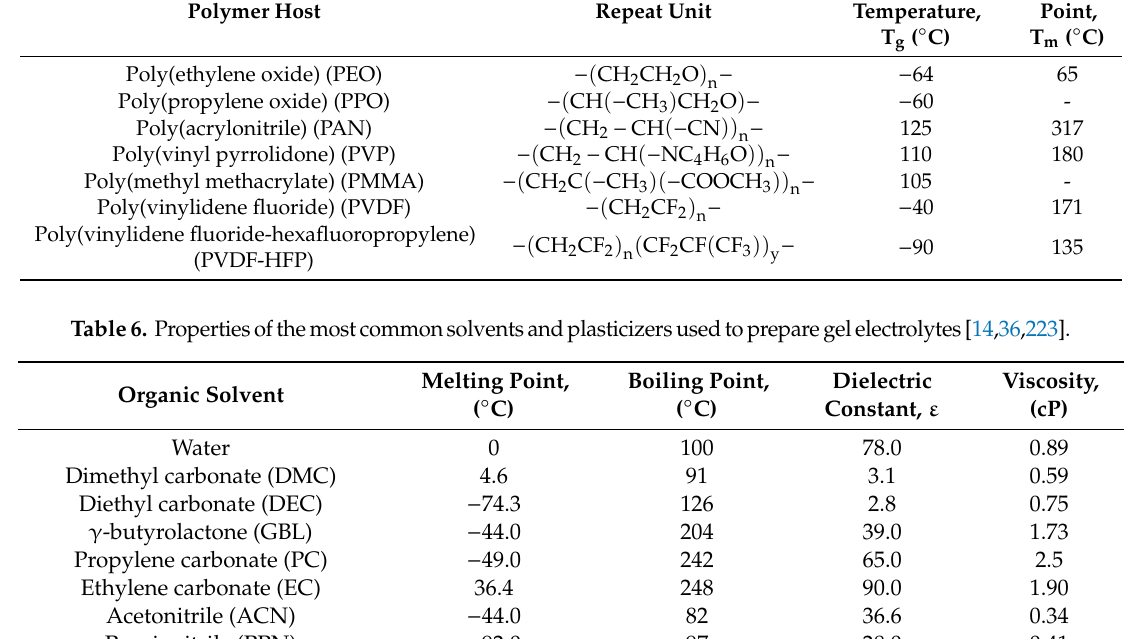
Table 5. Properties of the most common polymer matrices used to prepare gel electrolytes [36,200,222]. Polymer Host